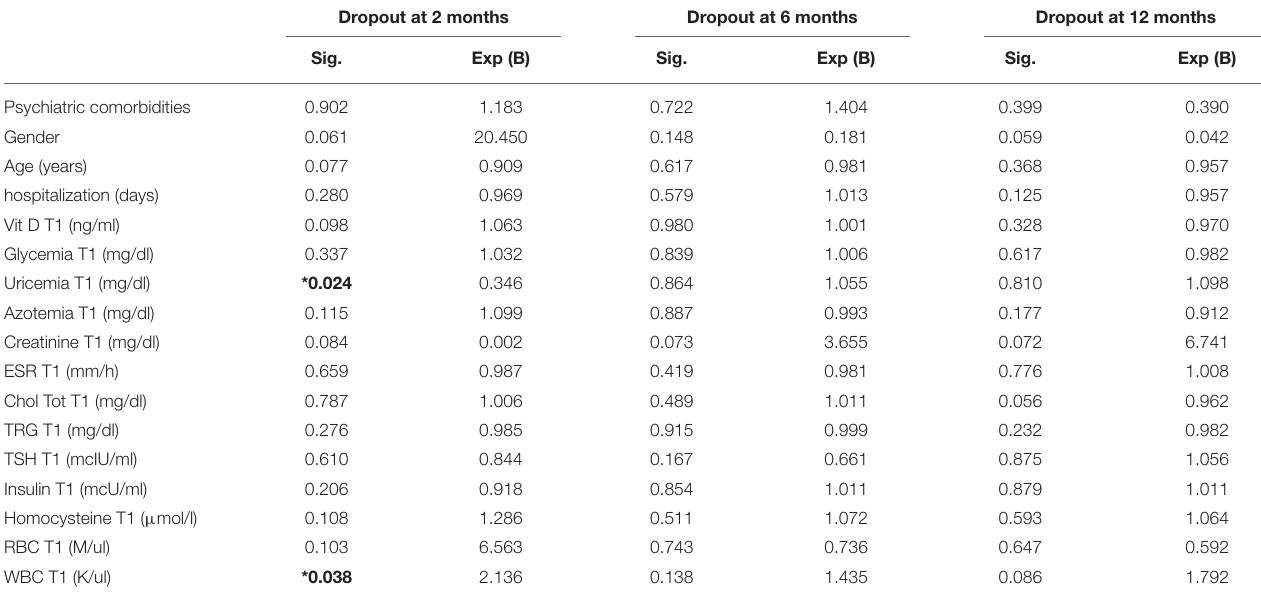
TABLE 6 | Binary regression of dropout risk at 2, 6, and 12 months considering the biochemical measures after the discharge of MRP. Dropout at 2 months Dropout at 6